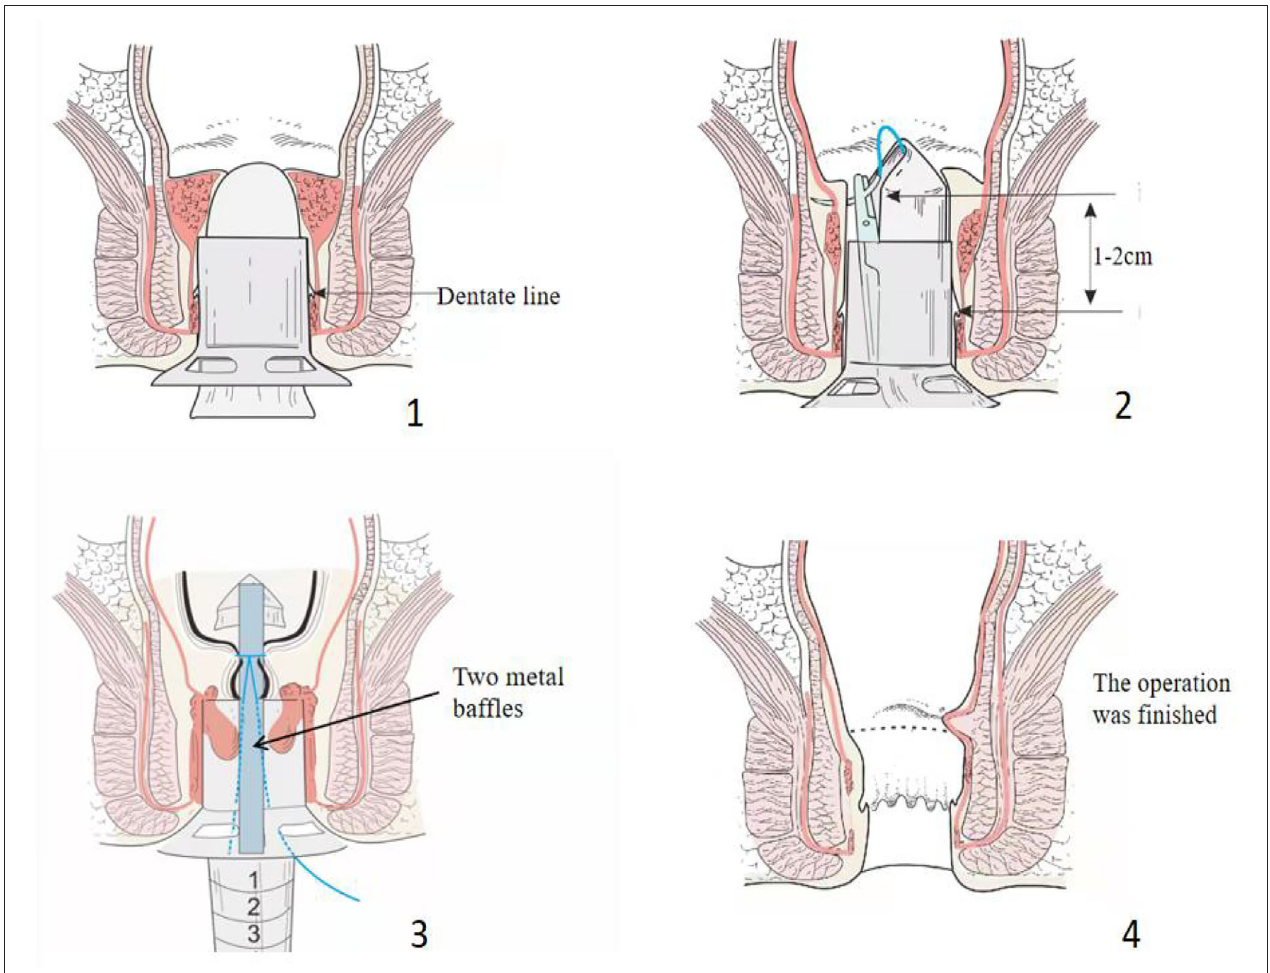
FIGURE 3 | The modified technique shown in drawings to allow for a correct reproduction of the